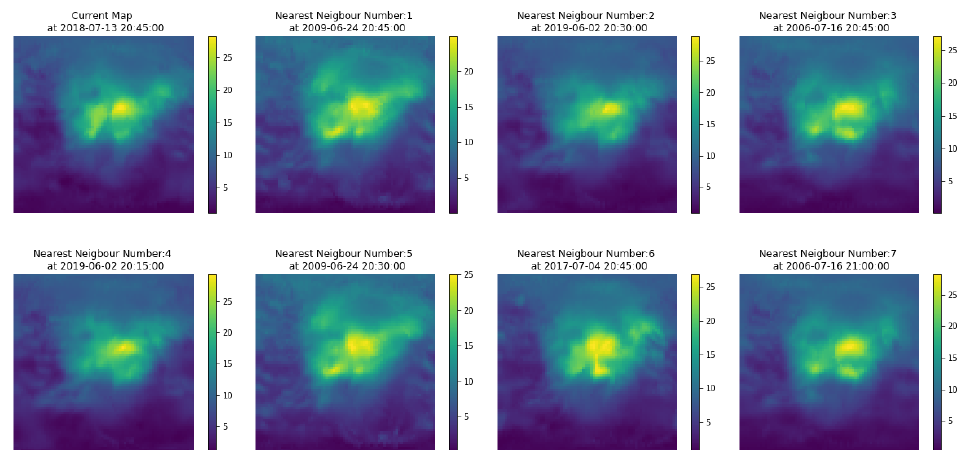
Figure 2. Current map at 2018-07-13 20:45:00 UTC (subplot at upper left corner), and the seven Nearest Neighbours. All maps in sun-fixed geomagnetic coordinates. The maps range in latitude from 90 degrees north to 90 degrees south, and in longitude from 180 degrees west to 180 degrees east. Color bars are in TEC